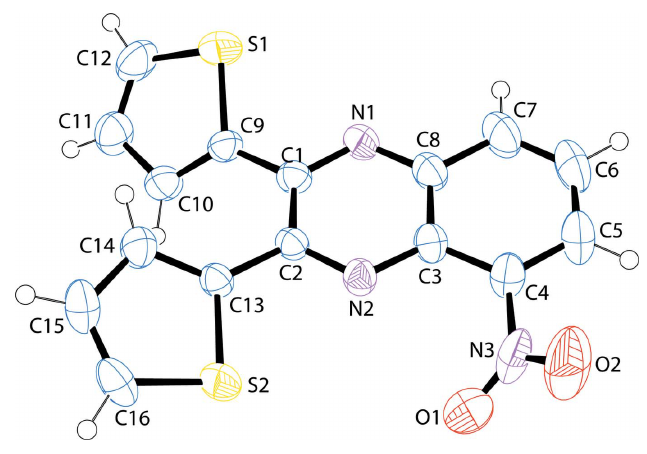
Figure 1 A view of 5-nitro-2,3-bis(thiophen-2-yl)quinoxaline (Farrugia, 2012). Displacement ellipsoids are drawn at the 50% probability level.